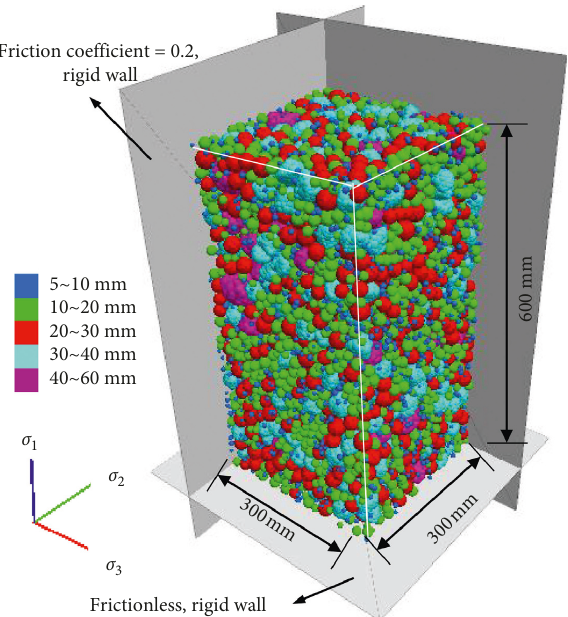
Figure 16: Three-dimensional model ( F